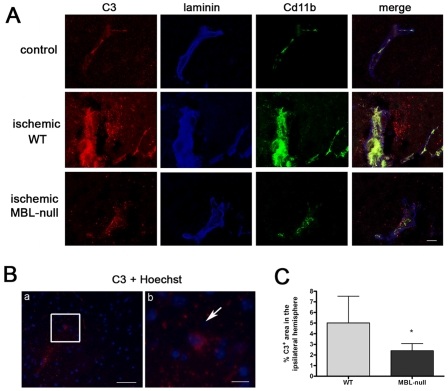
Ischemia-induced C3 deposition in brain parenchyma is attenuated in MBL-null versus WT mice.A) C3 deposition (red), laminin immunostaining (blue), and CD11b (green). C3 immunoreaction is often associated to vessels and it is also found within the ischemic brain parenchyma. The C3 reaction is more moderate in MBL-null mice than in the WT. Control indicates non-operated WT mice. Bar scale  = 10 µm. B) C3 deposition (red) and Hoechst counterstaining to illustrate the cell nuclei shows C3 immunoreaction surrounding certain cell bodies (arrow in b). (b) is a magnification of the square shown in (a). C) Quantification of the C3 immunoreactive area in the ipsilateral hemisphere shows a significant reduction in MBL-null mice (n = 5) versus the WT (n = 5). Values are expressed as the mean±SD. Bar scale: (a) 100 µm, (b) 10 µm. * indicates p<0.05.